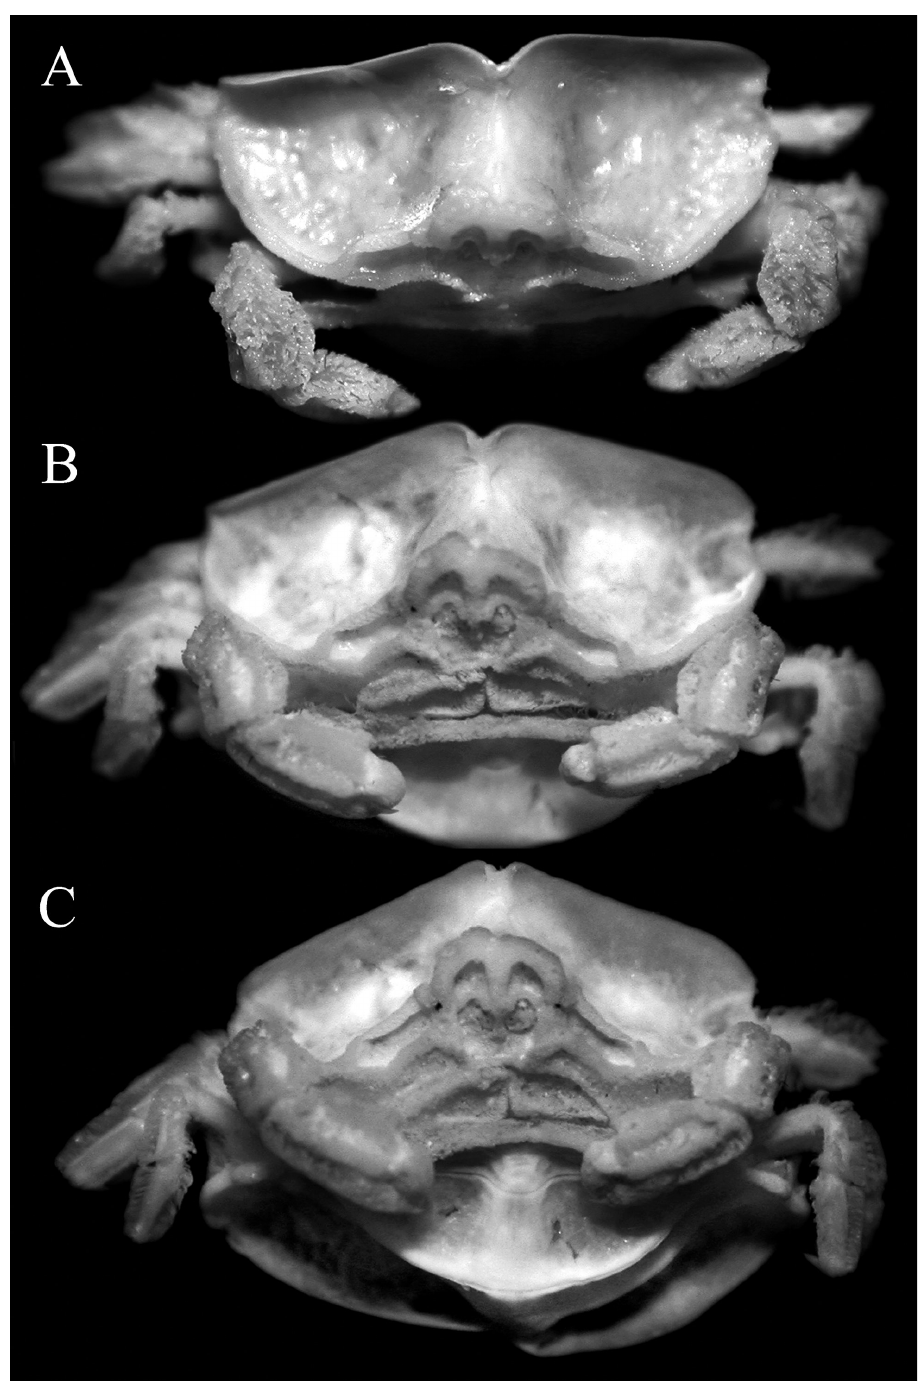
Figure 3. Serenotheres janus sp. n., holotype ♀ (8.9 × 7.9 mm) (USNM). Frontal views of